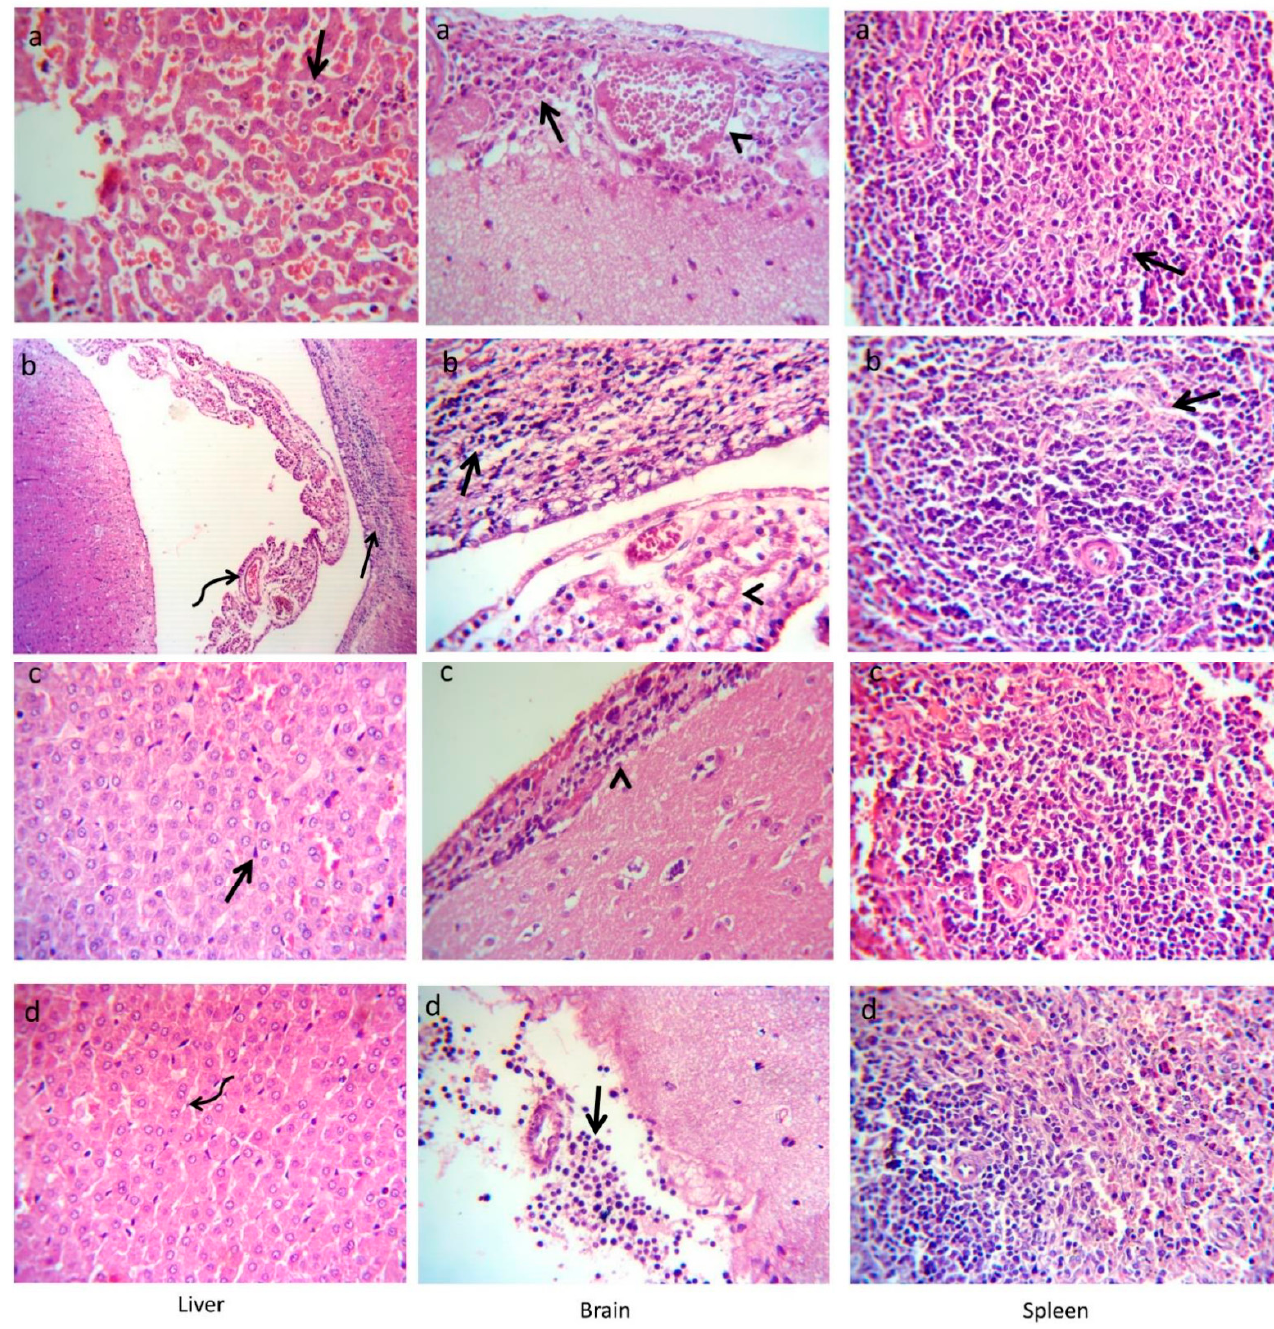
Figure 8. Histopathological alterations of rabbits’ liver, brain, and spleen at 14-days post L. mono- cytogenes experimental infection. ( a ) PC: positive control (rabbits fed a basal diet and experimentally infected with L. monocytogenes ). Neutrophilic infiltrations within sinusoids (arrow) in hepatic parenchyma. Meningeal congestion (arrowhead) and leukocytic infiltrations, mainly neutrophils (arrow), in the brain tissue. Shrinkage of some lymphoid follicles and necrotic changes of some lym- phoid elements (arrow) in the spleen. ( b ) PC+ENR: rabbits fed a basal diet, experimentally infected with L. monocytogenes, and treated with enrofloxacin. Thrombus (curved arrow) in the blood vessels and neutrophilic infiltrations within sinusoids (arrow) in hepatic parenchyma. Meningeal congestion (arrowhead) and leukocytic infiltrations, mainly neutrophils (arrow), in the brain tissue. Shrinkage of some lymphoid follicles and necrotic changes of some lymphoid elements (arrow) within the spleen. ( c ) MSPP: rabbits fed a basal diet supplemented with MSP at the level of 1 × 10 8 CFU/kg from 30